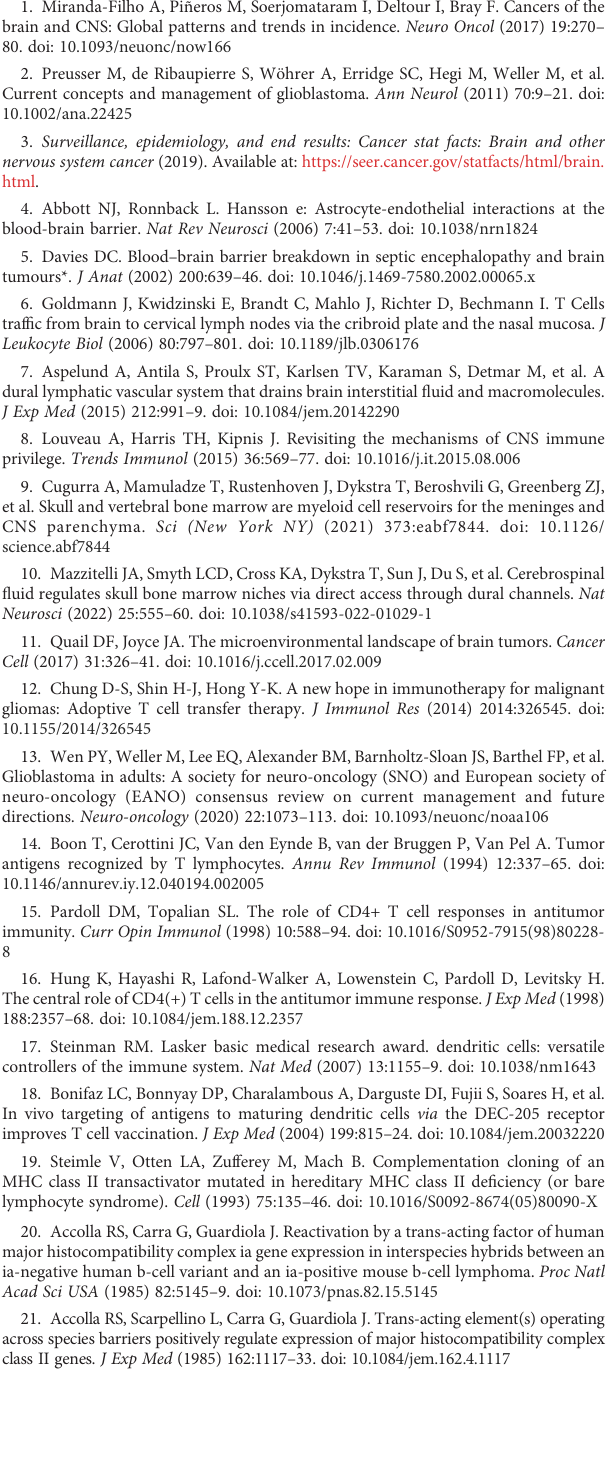
brains were removed, and serial sections of the brain were carried out to be stained with anti-CD3, anti-CD4, anti-CD8, anti-FoxP3, anti-CD19, and anti- CD161 antibodies. Bar graphs represent the average number of CD3, CD4, CD8, FoxP3, CD19 and CD161 tumor in fi ltrating lymphocytes (TIL) measured from histopathological sections of GL261-CIITA at 21 (n=7) day or 42 (n=5) days post-injection. Data are represented as mean values and error bars indicate the SD of each